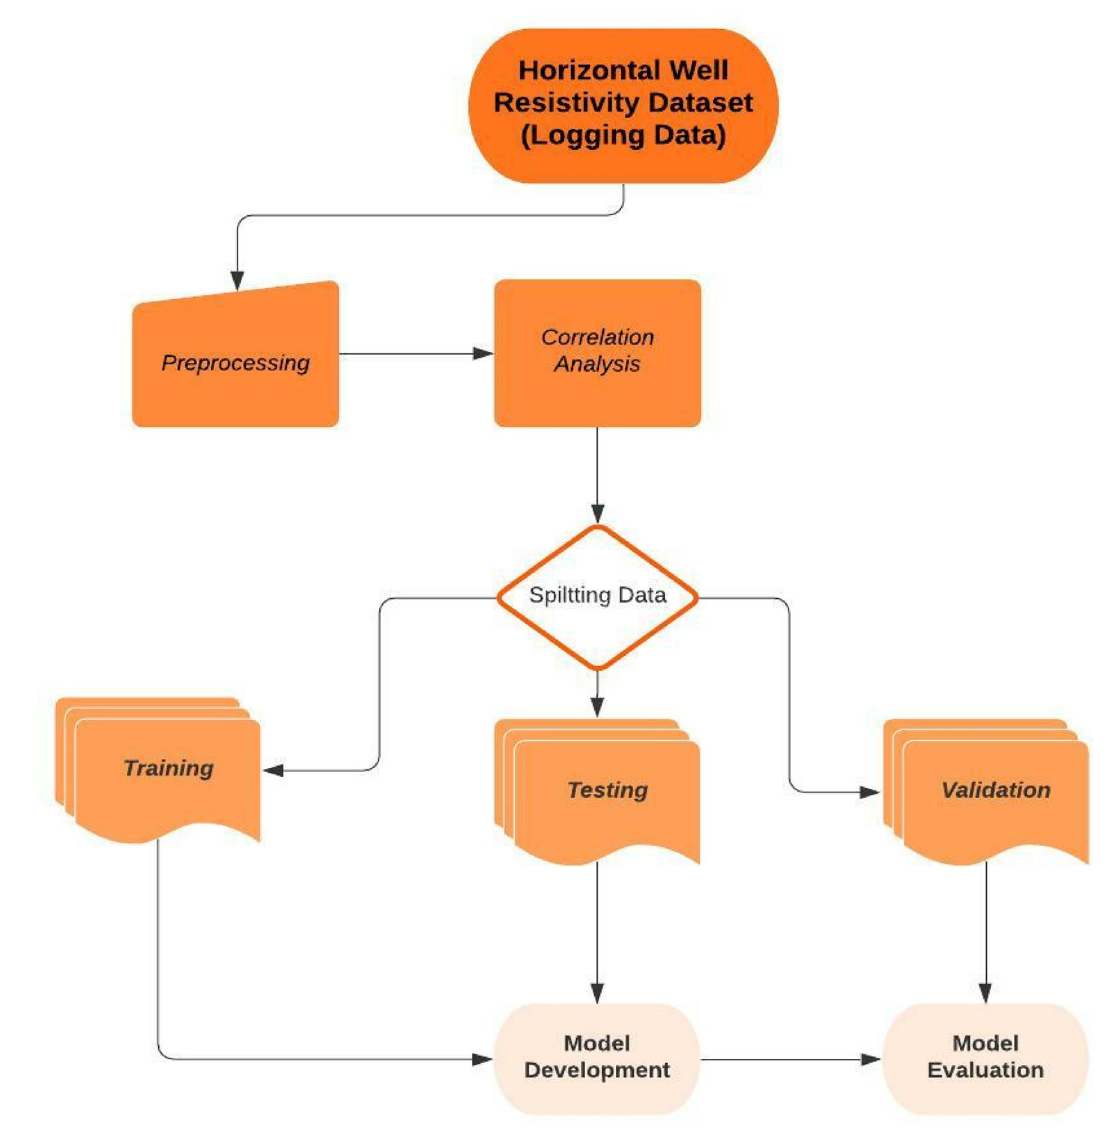
Fig. 1 General flowchart for building DT and RF models